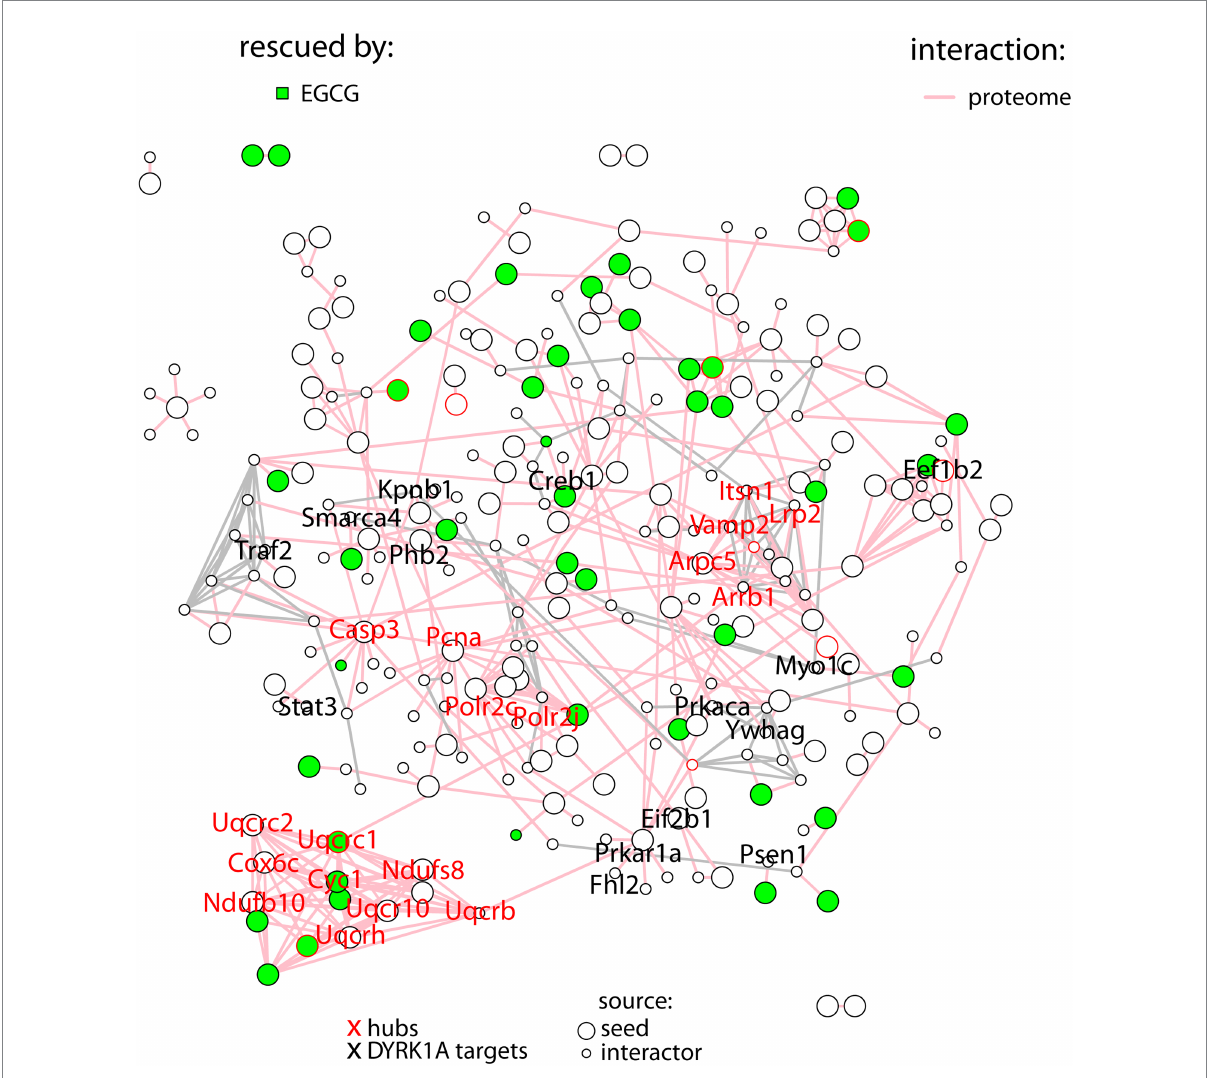
FIGURE 2 Protein–protein interaction network with the proteins differentially abundant in TG mice ( seed proteins), represented as big nodes and their primary interactors (small nodes). Interactions between two seed proteins are depicted as pink edges. Interactions between interactors are shown in gray. Proteins rescued upon treatment are colored in green. The names of the hubs are depicted in red, the names of DYRK1A targets in